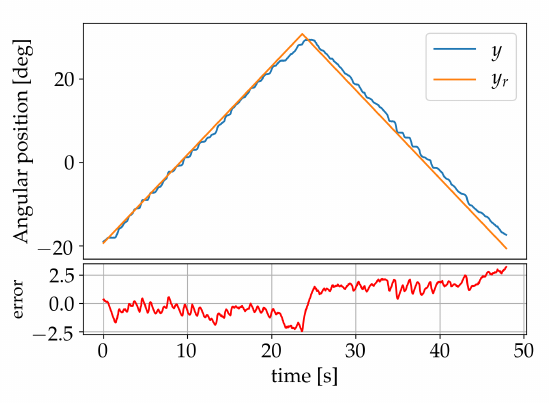
Figure 15. Results for a triangle wave